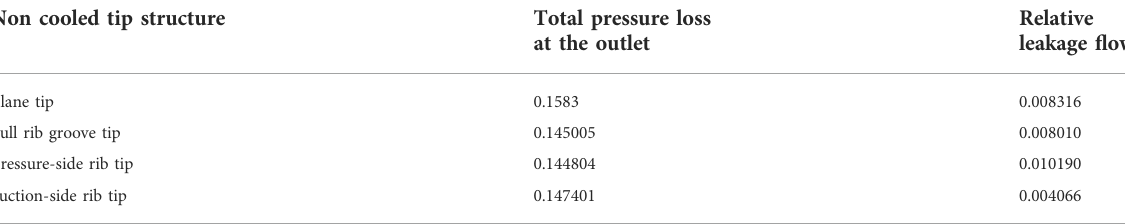
TABLE 4 Outlet aerodynamic parameters of different non-cooled tip structures.